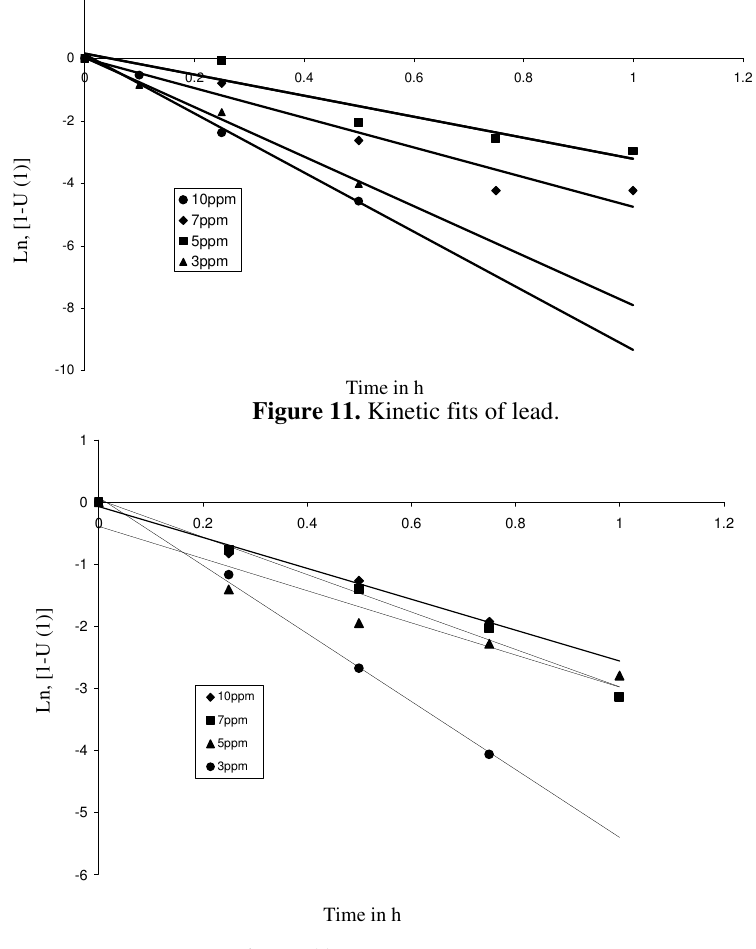
Time in Figure 12. Kinetic fits of mercury.